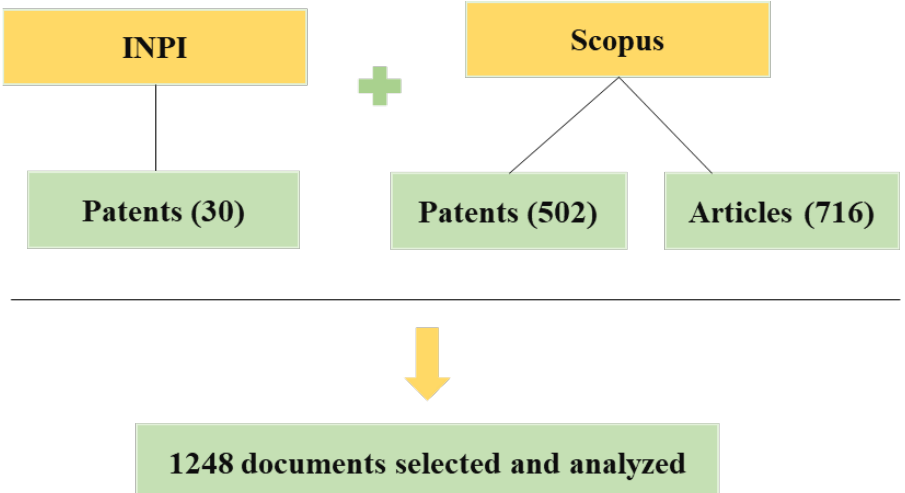
Figure 1. Flowchart for the selection of patents and articles.